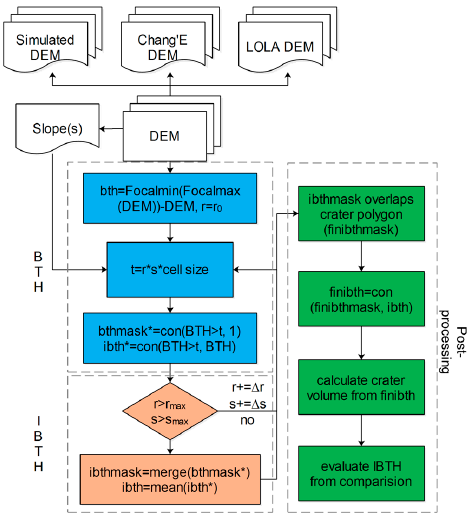
Figure 3. Workflow diagram of Iterative Black Top Hat (IBTH) algorithm.